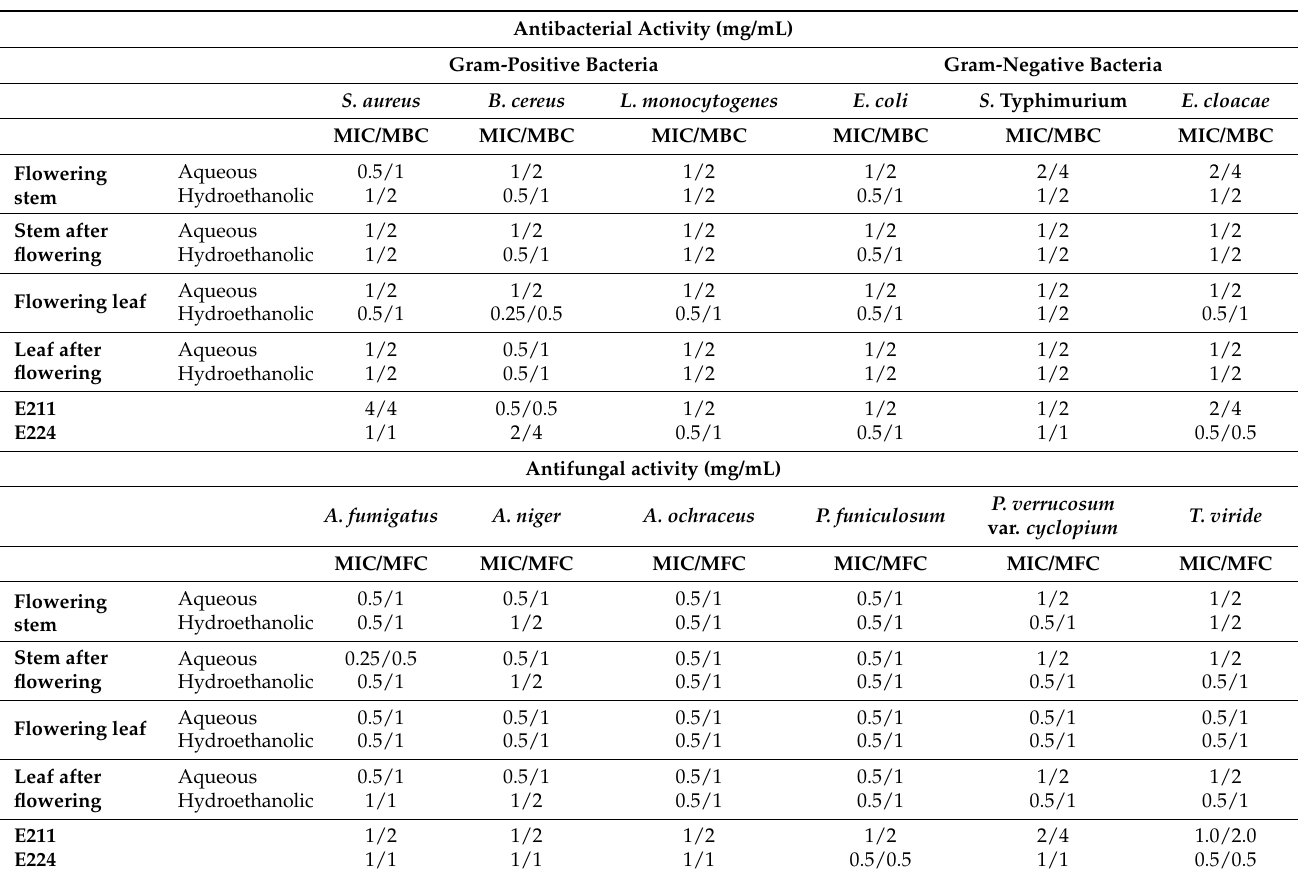
Table 6. Antimicrobial and antifungal activity of the hydroethanolic and aqueous extracts of C. erecta (mean ± SD, n = 3